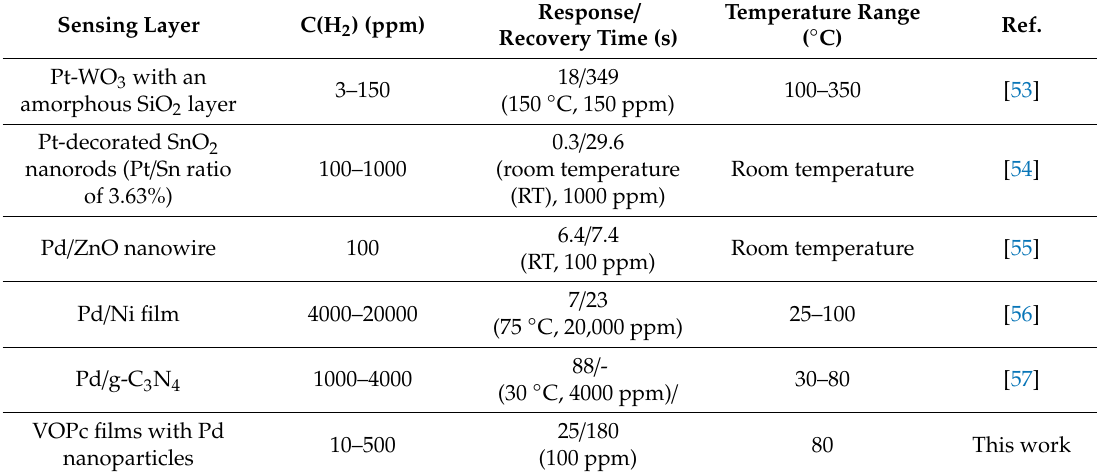
Table 2. Characteristics of various sensors for hydrogen detection.